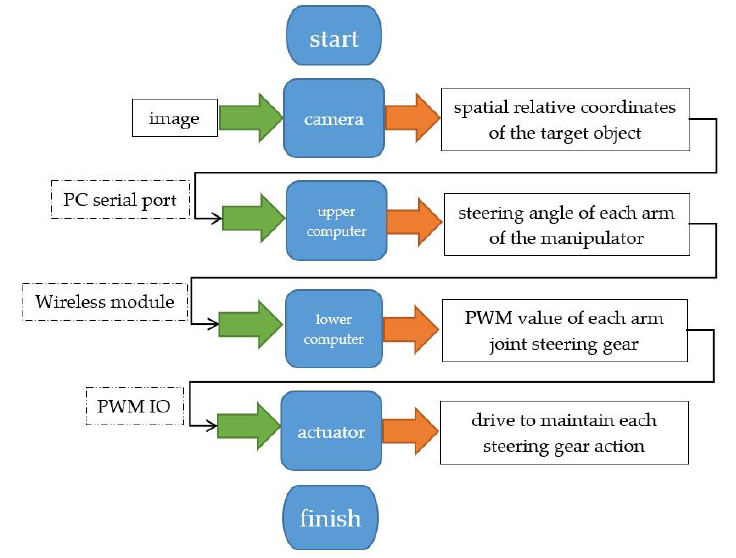
Figure 4. The underlying models for robot control.